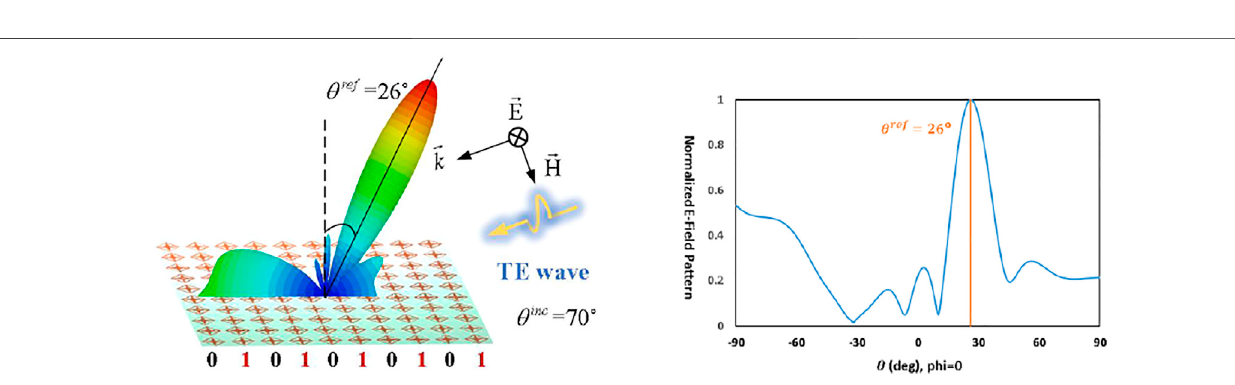
FIGURE 7 | Electrical fi eld pattern of the proposed programmable metasurface under TEM wave illumination at an oblique angle of 70 o .